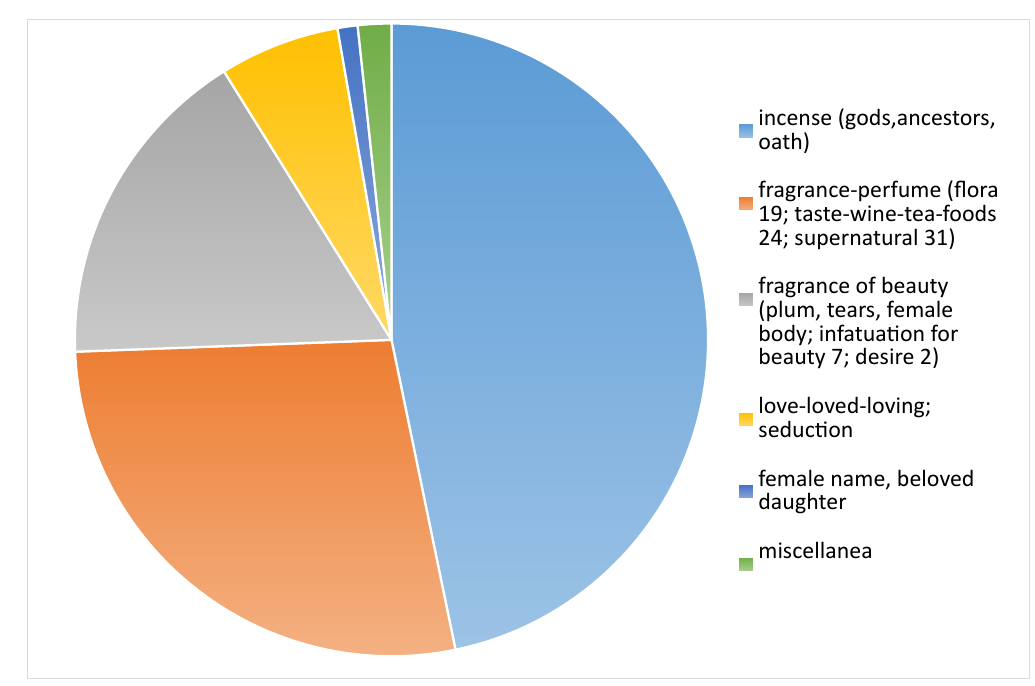
incense (gods,ancestors,